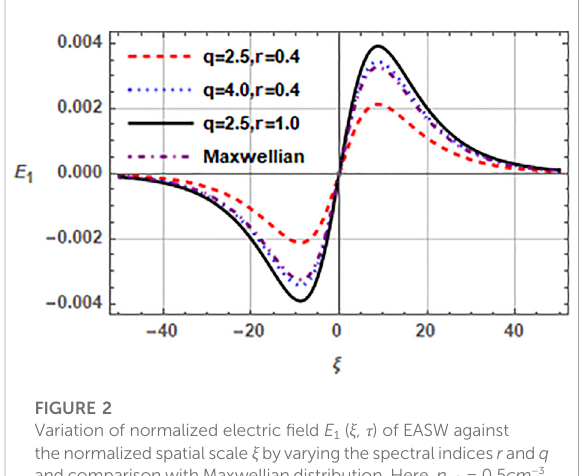
FIGURE 3 Variation of normalized electric fi eld E 1 ( ξ , τ ) of EASW against normalized ξ by varying the streaming speed of beam electron v b